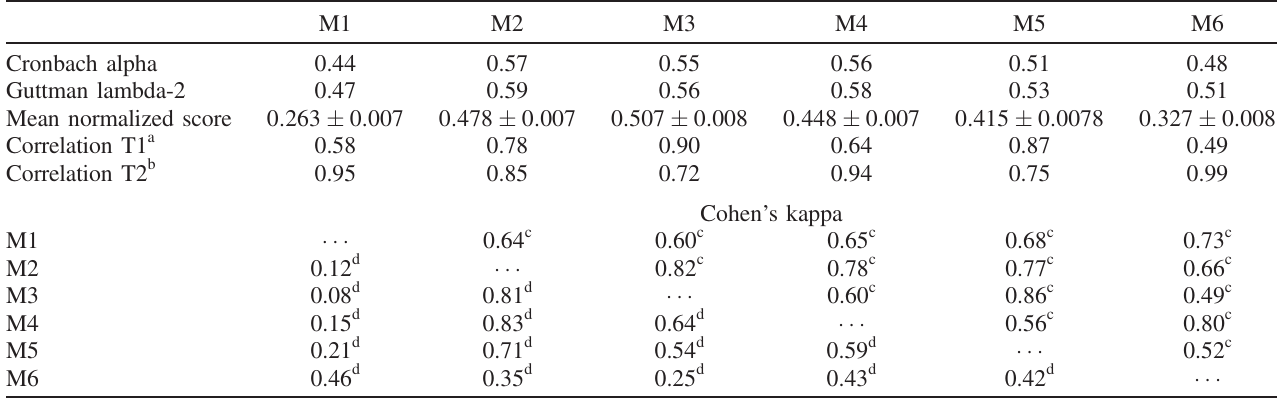
TABLE VI. Classical reliability indices and correlations between total score and tiers scores for QME (coupled tiers). M1